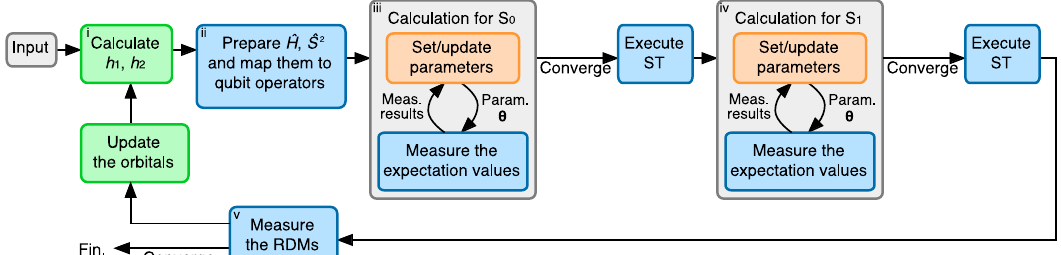
Fig. 8 Schematic diagram of SA-CASSCF program. Green, blue and orange boxes indicate that PySCF, Qiskit, and SciPy packages were used,